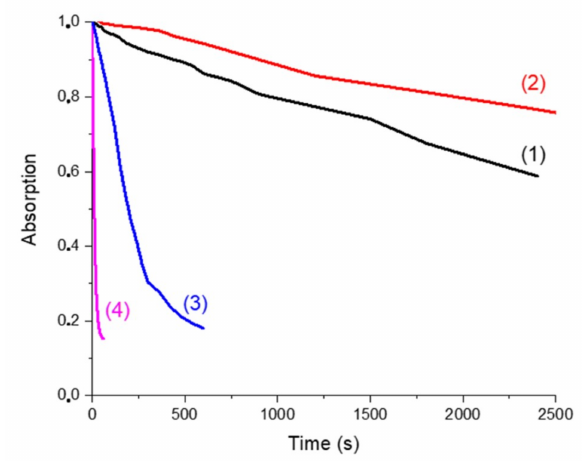
Figure 7. Photolysis monitored by the decay of the absorption @405 nm (percentage of decay of the absorption peak at 405 nm vs. irradiation time of the solution upon LED exposure in the presence of Napht-B1: (1) alone; (2) with 4-dppba (5.10 − 2 M); (3) with Ar 2 I + PF 6 − (4.10 − 2 M) and (4) with 4-dppba (5.10 − 2 M) and Ar 2 I + PF 6 − (4.10 − 2 M) in